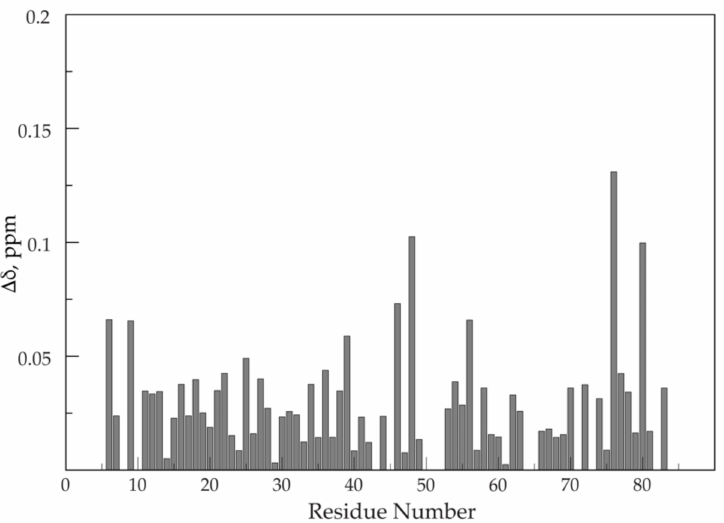
Figure 5. Small chemical shift differences between wilt-type sapC and sapC domain of sapC-PUMA: Combined amide 1 H and 15 N chemical shift differences of sapC and sapC-PUMA versus amino acid